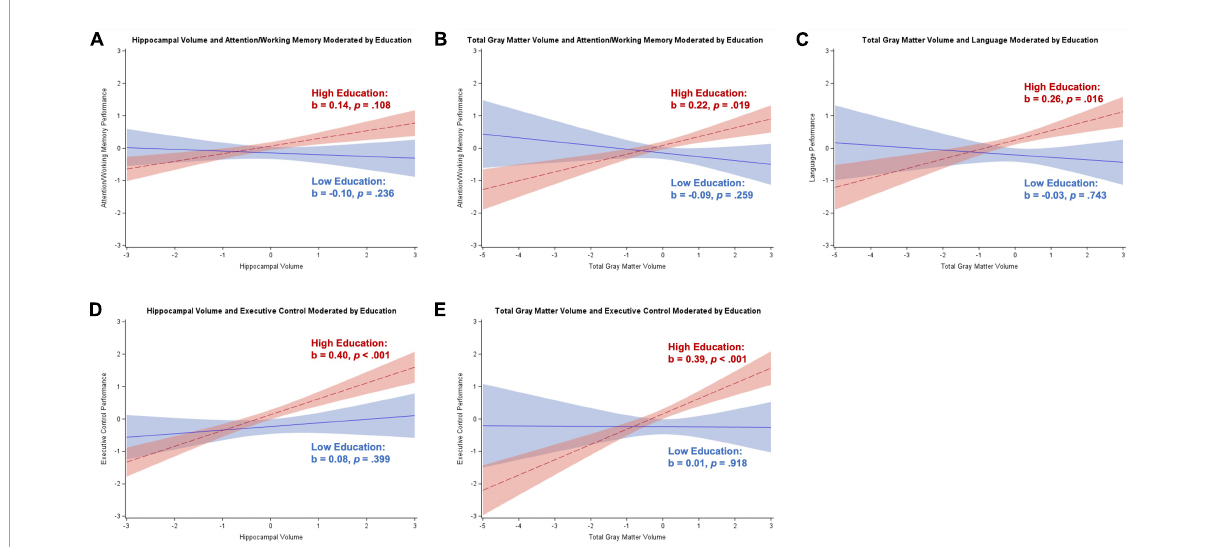
FIGURE3 Plots of significant moderations by education of the associations between brain volume and cognition for participants with subjective cognitive decline. High education corresponds to 1 SD above the mean and low education corresponds to 1 SD below the mean. The red dotted line represents high education, and the blue solid line represents low education. Shaded areas represent 95% confidence intervals. Cognition and brain volume were standardized. (A) Non-significant positive association between hippocampal volume and attention/working memory for participants with high education; non-significant negative association for low education. (B) Significant positive association between total gray matter volume and attention/working memory for participants with high education; non-significant negative association for low education. (C) Significant positive association between total gray matter volume and language for participants with high education; non-significant negative association for low education. (D) Significant positive association between hippocampal volume and executive control for participants with high education; non-significant positive association for low education. (E) Significant positive association between total gray matter volume and executive control for participants with high education; non-significant positive association for low